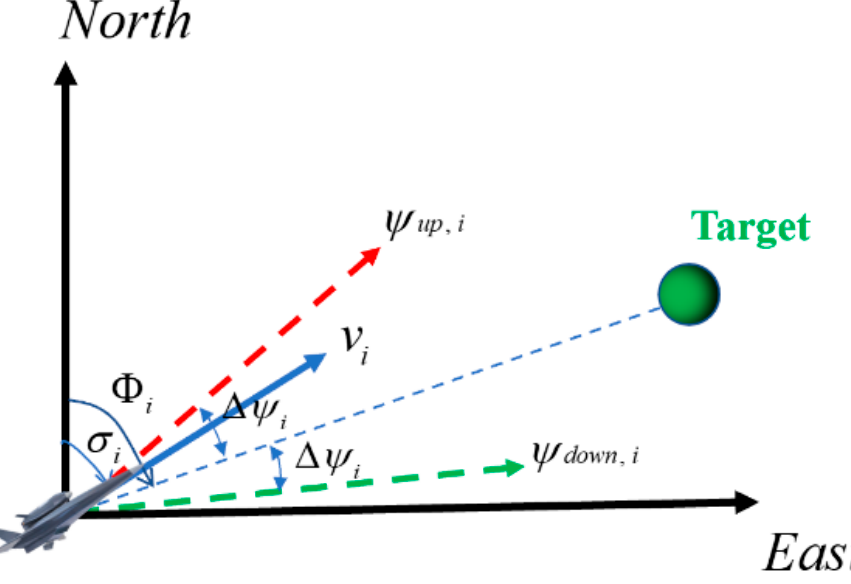
Figure 3. The sketch of heading error corridor.